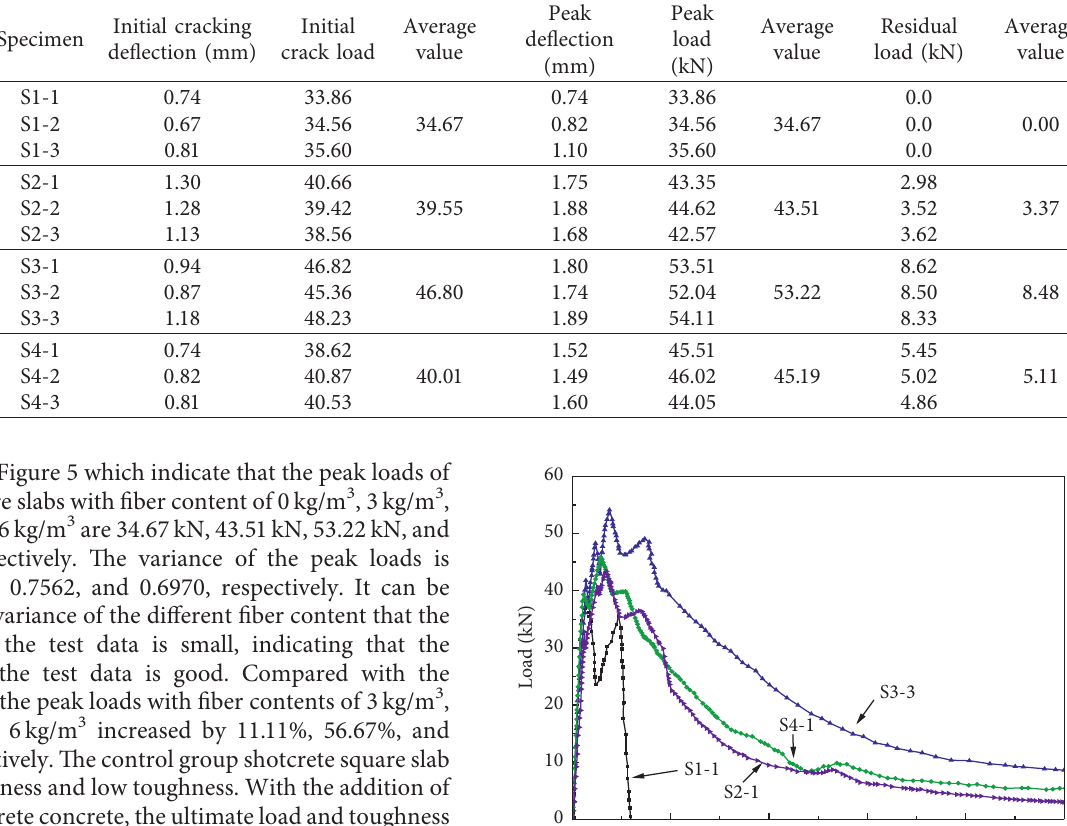
Table 4: Test results of mechanical properties of BF reinforced concrete square slabs.